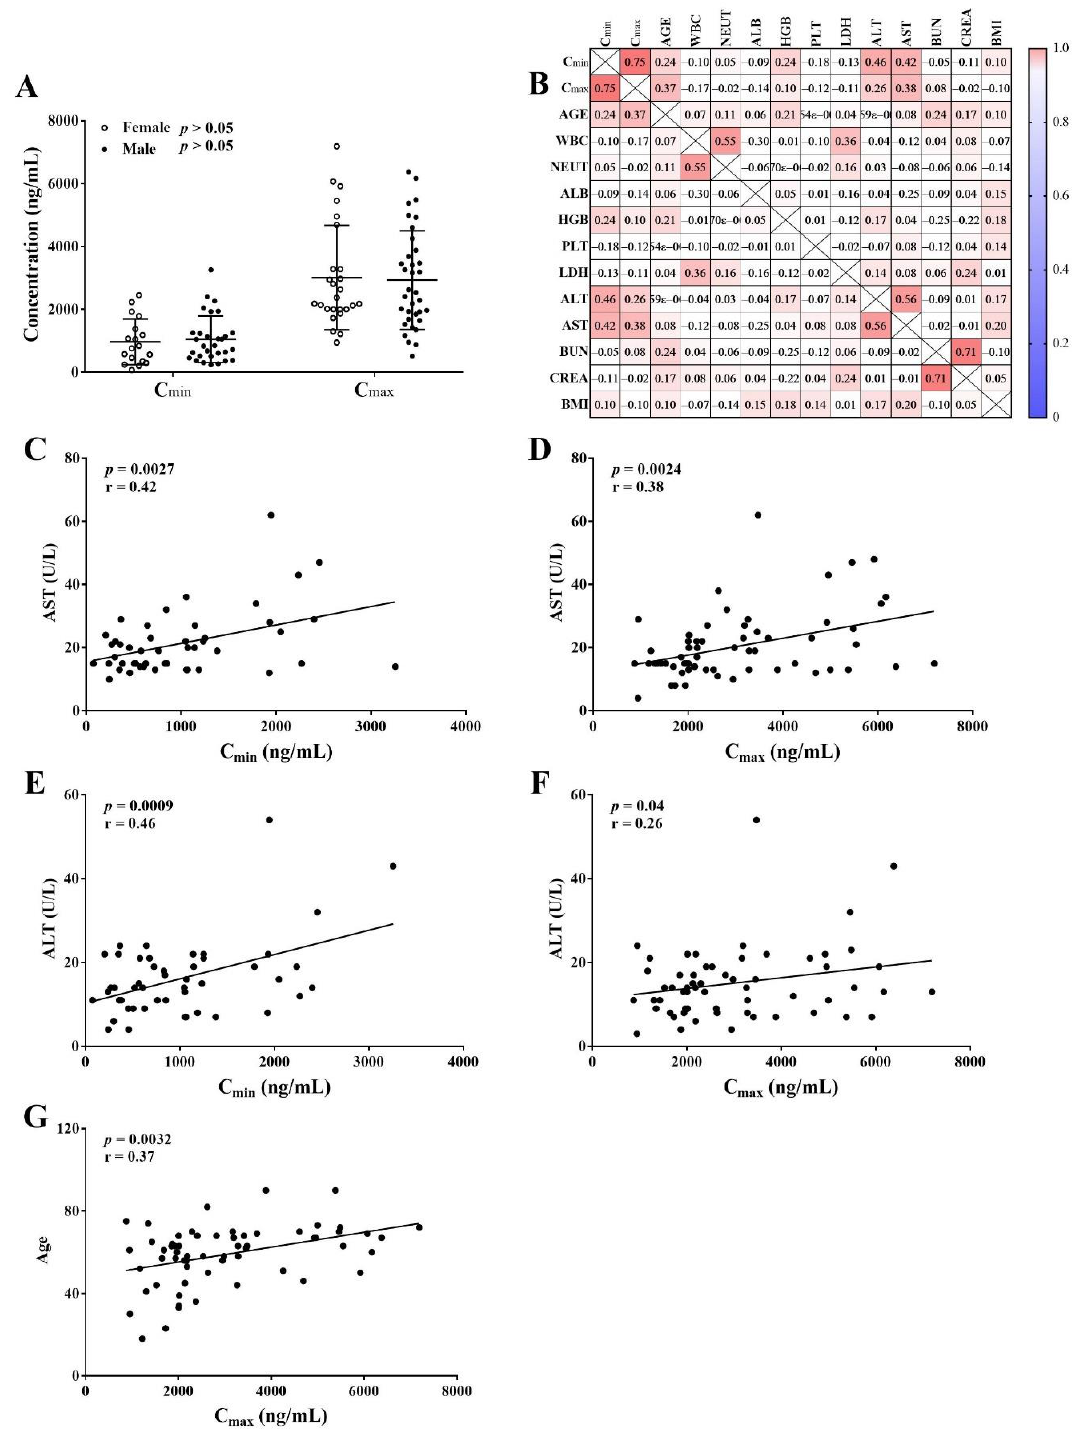
Figure 4. Variables associated with the venetoclax concentrations. The venetoclax concentrations in the female cohort were similar to the male cohort ( A ). The correlation heatmap between venetoclax concentrations and clinical features ( B ). The AST concentration and the venetoclax concentration were positively associated ( C , D ); The ALT showed a relevant effect on C min rather than C max ( E , F ); The age and the C max of venetoclax were positively associated ( G ). WBC, white blood cell count; NEUT, neutrophil; HGB, hemoglobin; ALB, albumin; PLT, platelet; LDH, lactate dehydrogenase; ALT, alanine aminotransferase; AST, aspartate transaminase; BUN, blood urea; CREA, creatinine.